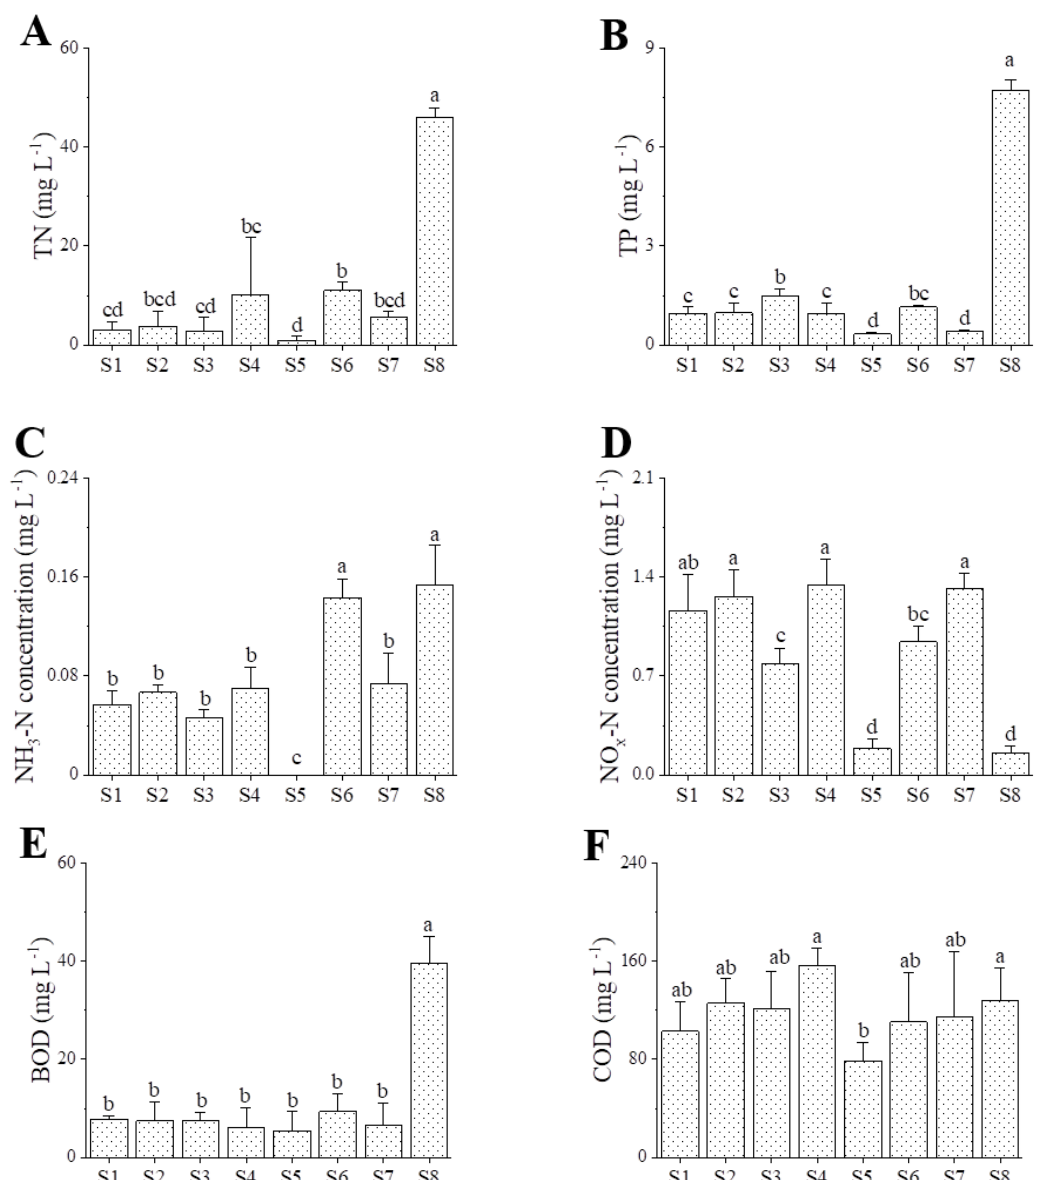
Figure 4. Concentrations of TN ( A ), TP ( B ), NH 3 -N ( C ), NO X -N ( D ), BOD ( E ), and COD ( F ) of S1–S8 from or near K. obovata and S. caseolaris communities on the west coast of Bao’an, Shenzhen. Mean ± SD of three replicates were shown. Different small letters indicate significant differences among the concentrations of TN, TP, NH 3 -N, NO X -N, BOD, and COD of S1-S8 at p < 0.05. Note: In the abscissa, “S1” means seawater collection point 1, and so